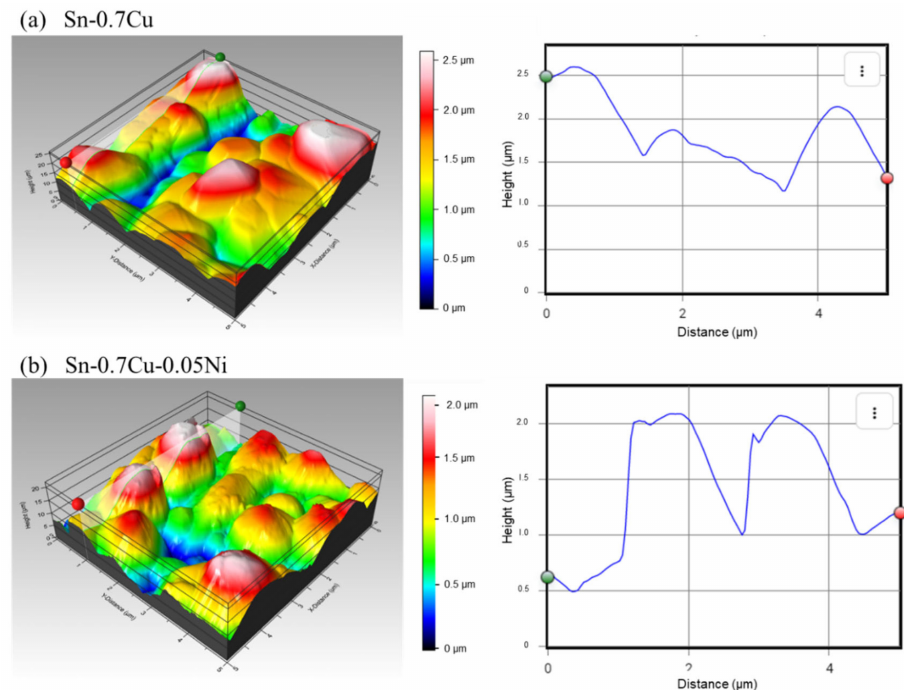
Figure 11. Atomic force microscope (AFM) three-dimensional (3D) images (5 × 5 µ m) of interfacial IMC formed from ( a ) Sn-0.7Cu and ( b )